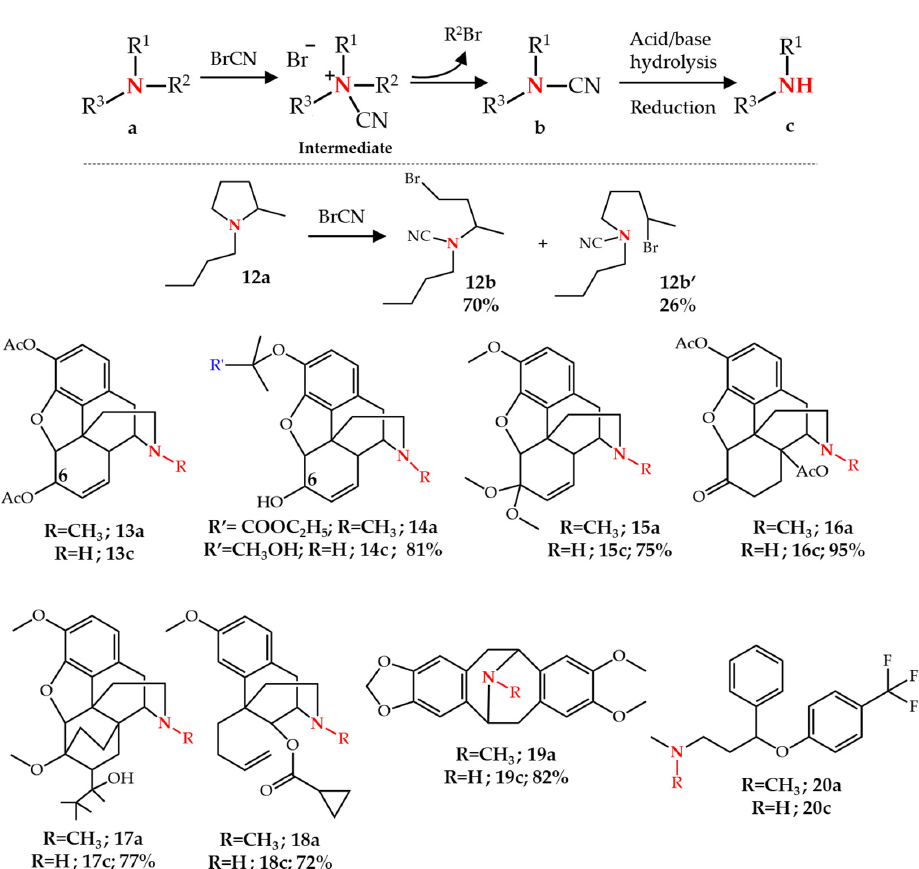
Figure 2. N ‐ Dealkylation of amines by the von Braun reaction. Figure 2. N -Dealkylation of amines by the von Braun